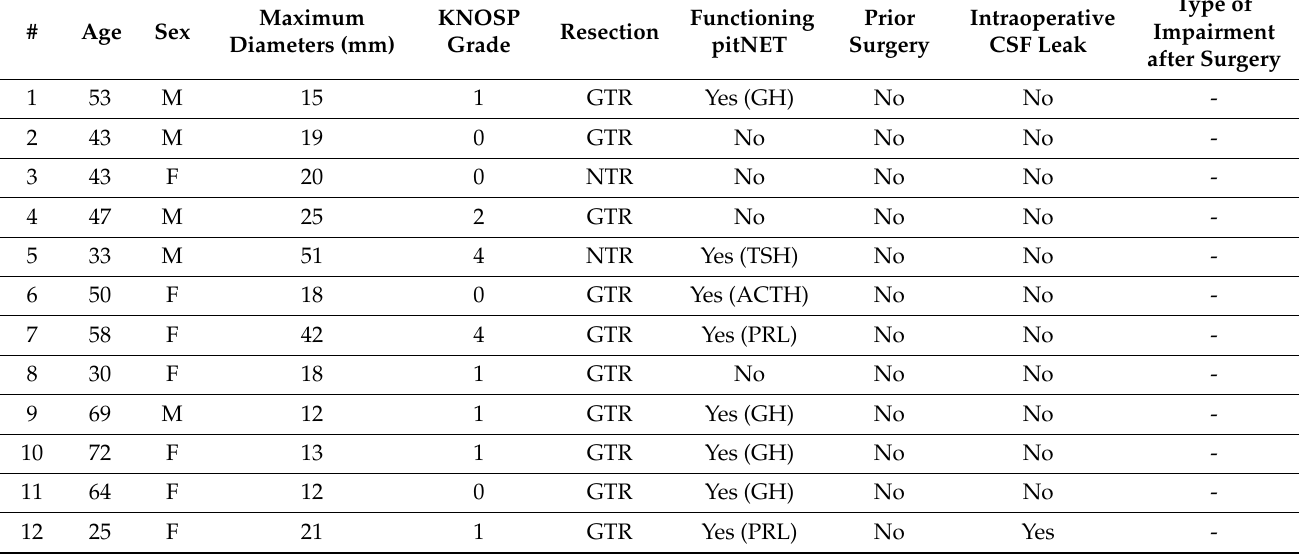
Table 1. Features’ description for patients who showed a pituitary gland recovery after endoscopic transsphenoidal surgery (group